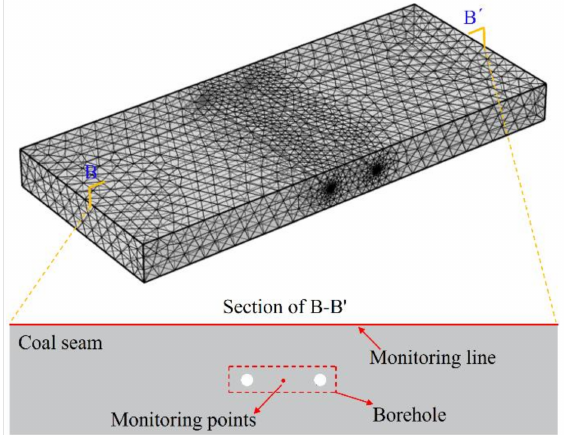
Figure 16. Numerical